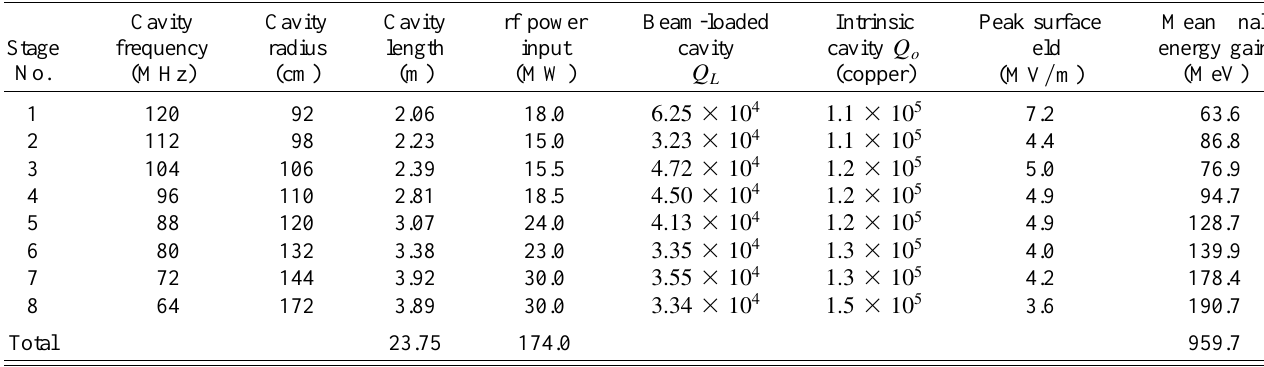
TABLE I. Parameters for an eight-cavity proton accelerator with 122 mA average current.